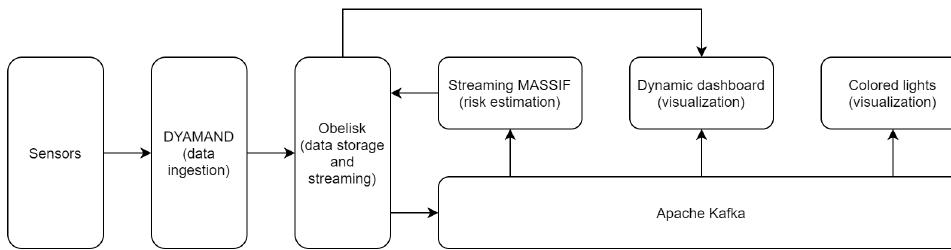
Figure 2. Overview of the microservice